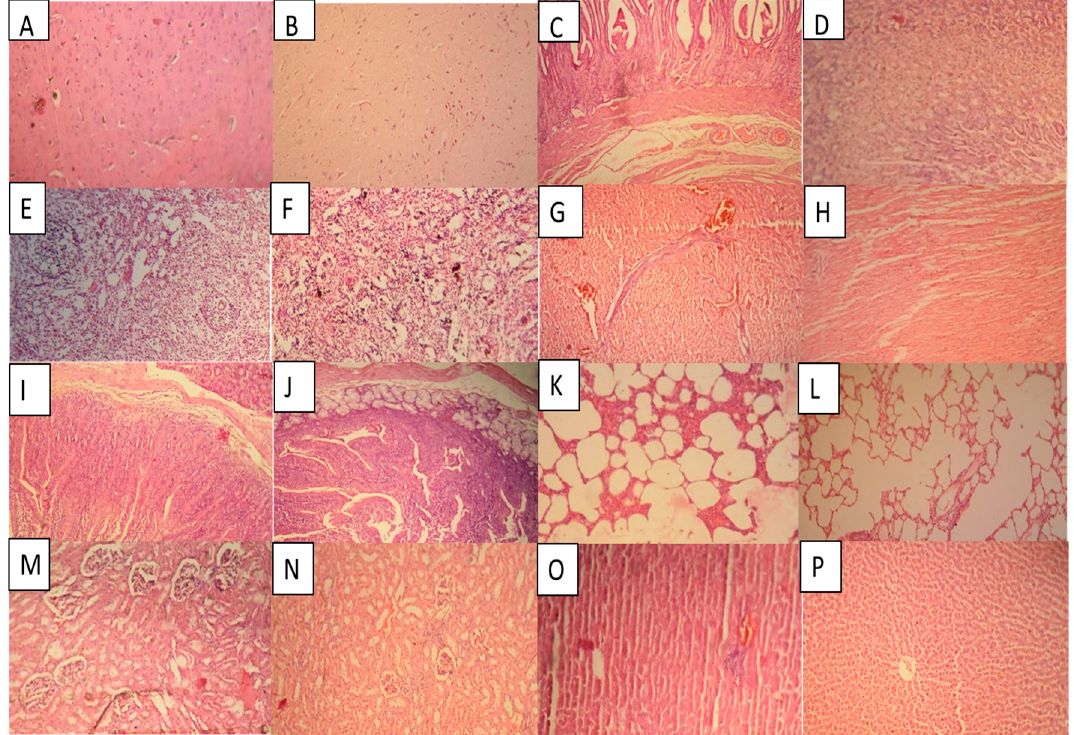
Figure 13. Histopathological examination of A = brain (control), B = brain (treated), C = stomach (control), D = stomach (treated), E = spleen (control), F = spleen (treated), G = heart (control), H = heart (treated), I = intestine (control), J = intestine (treated), K = lungs (control), L = lungs (treated), M = kidney (control), N = kidney (treated), O = liver (control), P = liver (treated).